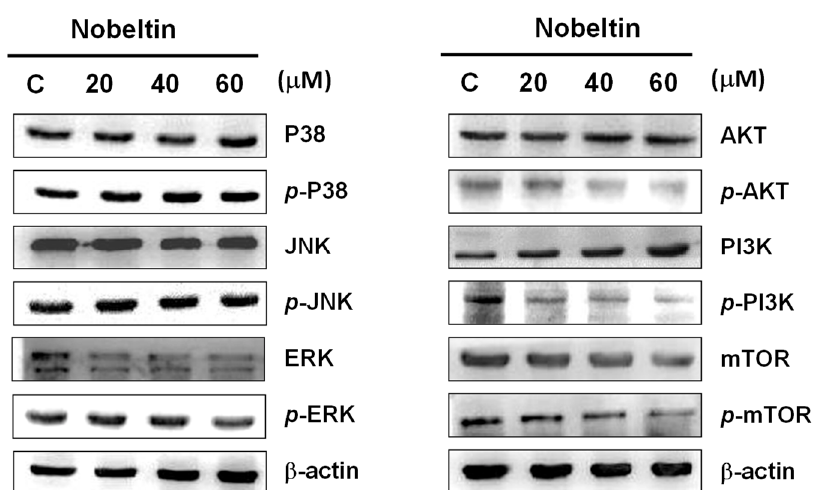
Figure 5. Western blot analysis of MAPKs and PI3K/AKT/mTOR signaling proteins in NOB-treated BFTC bladder cancer cells. BFTC cells were treatment with di ff erent concentrations of NOB (20–60 µ M) for 24 h. The protein lysates were subjected to western blot analysis with antibodies against p -p38, p38, p -JNK, JNK, p -ERK, ERK, p -AKT, AKT, p -PI3K, PI3K, p -mTOR, and mTOR. An antibody to β -actin used as the loading control.